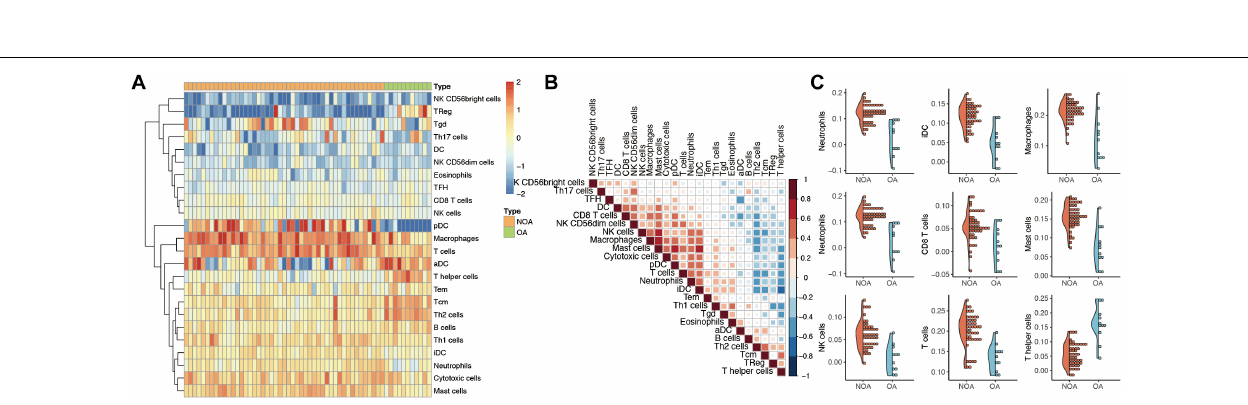
FIGURE 2 | Evaluation of immune infiltration in non-obstructive azoospermia (NOA). (A) Heat map showing the expression of each immune cell in each sample. The horizontal represents each sample. The samples are sorted in the order of NOA and OA. The vertical is each immune cell. Through clustering, we visualize the clustering of immune cells with similar expression. (B) Correlation analysis among various immune cells. The red in the figure represents a positive correlation between the two immune components. Blue means there is a negative correlation between the two. The darker the color, the stronger the correlation. (C) Immune components associated with NOA. The curve generation distribution density in the figure. Scattered points represent the immune infiltration score of each sample.